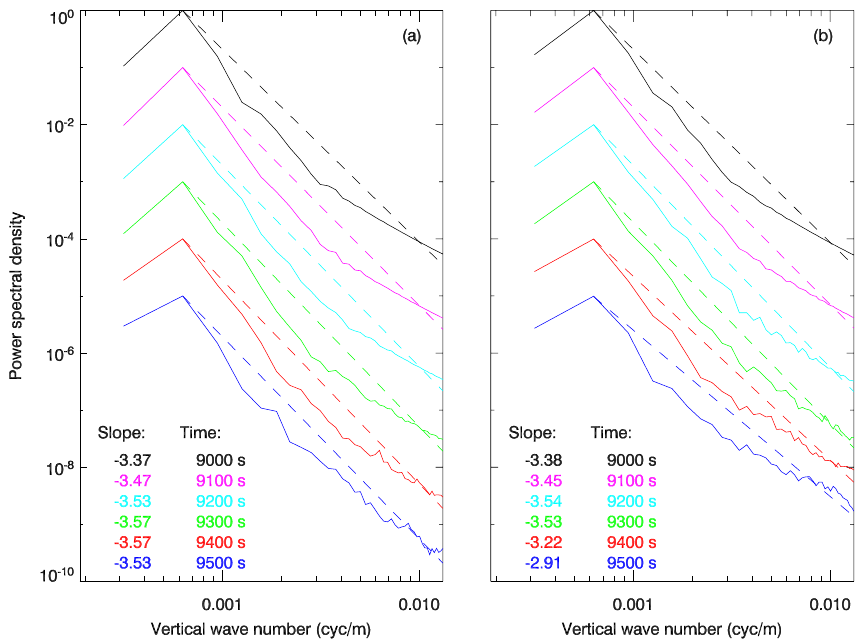
Fig. 4. Normalized PSD of the horizontal velocity (a) and temperature perturbations (b) versus vertical wave number. The PSD and their slopes at different times are shifted downward by a factor of 10 − 1 and identified by different